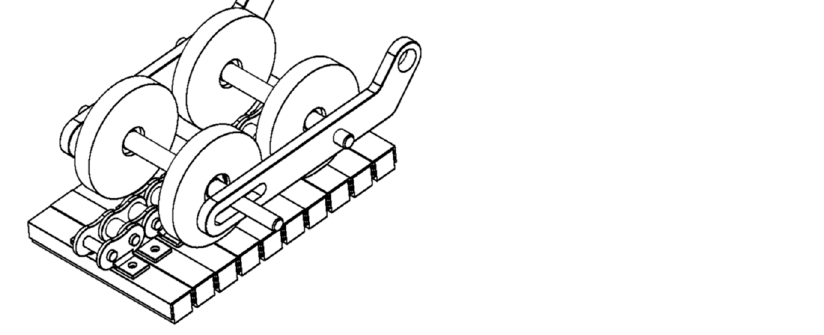
Figure 6. The undercarriage of the track module: rollers and L–shaped supports.